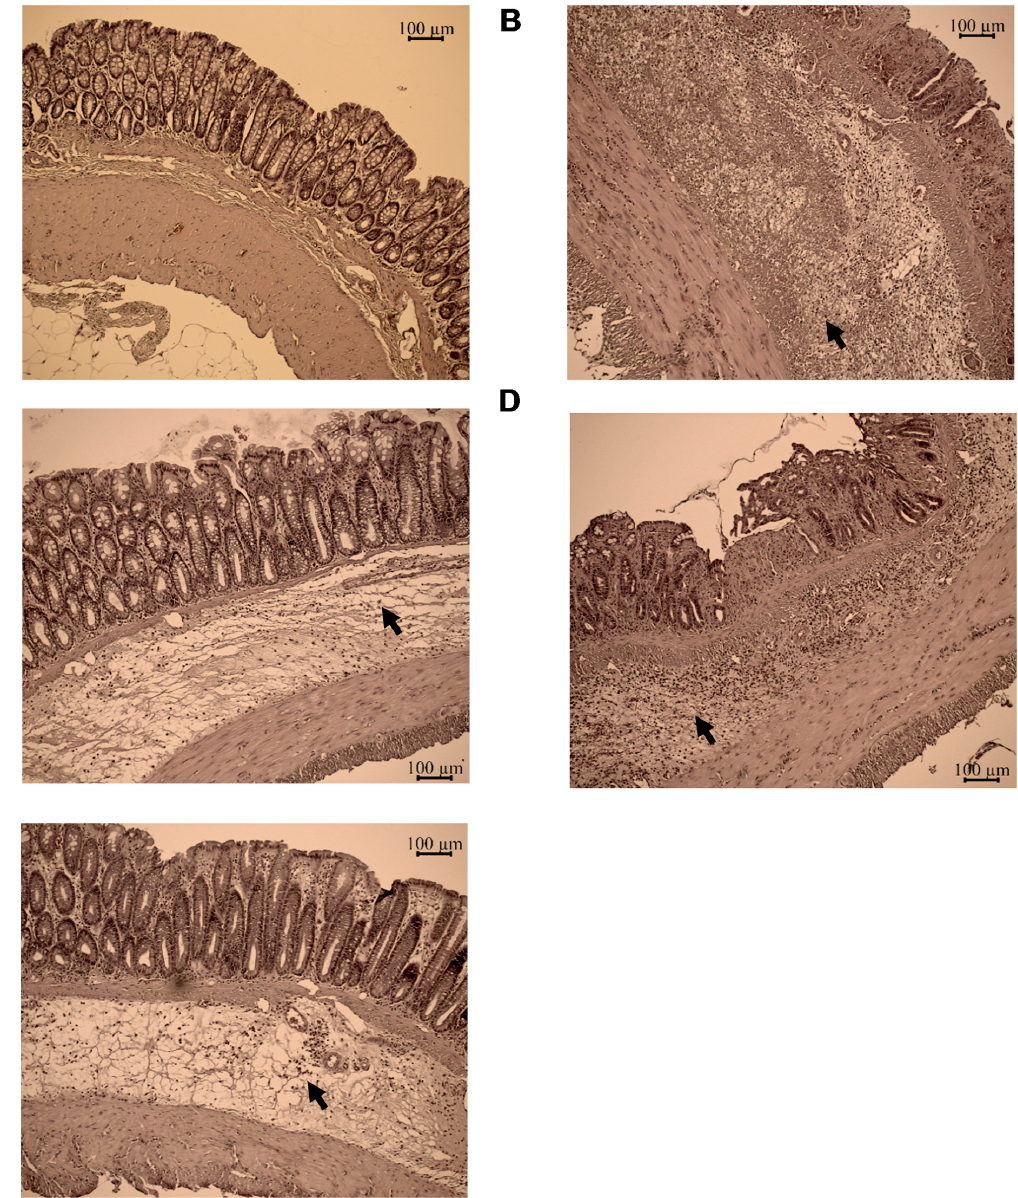
Figure 3. The TNBS-induced colitis developed to local inflammation (tissue oedema and infiltration of inflammatoy cells, arrowheads) in the colon. Experimental groups were as follows: ( A ) Absolute control, ( B ) TNBS-induced colitis, ( C ) TNBS + C142, ( D ) TNBS + C150, and ( E ) TNBS + Infliximab. Representative H and E images of colon preparations after treatments as described in Section 4.4 in Materials and Methods. Scale bar = 100 μ m.